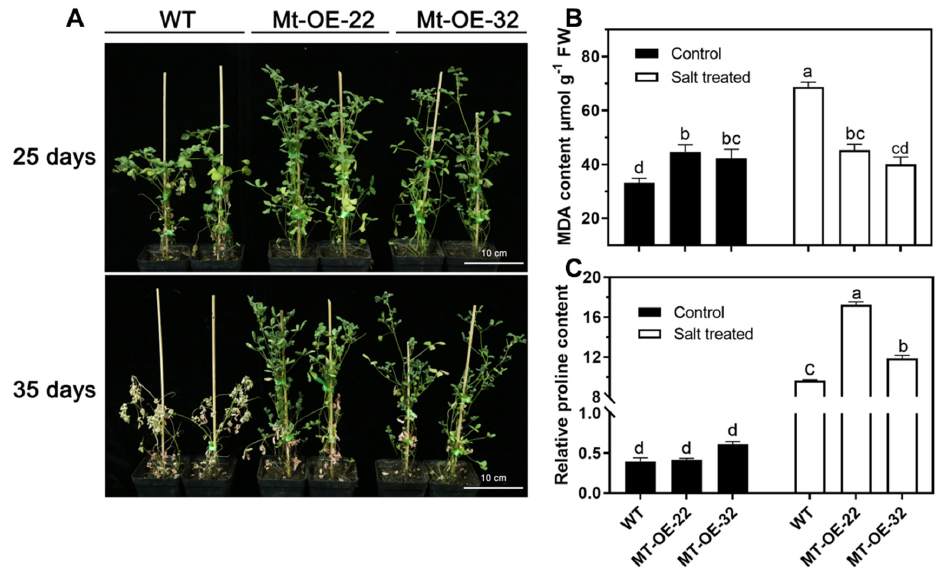
Figure 4. Growth and physiological differences of Mtr-miR319a- overexpressed M. truncatula plants after salt stress: phenotype ( A ); physiological indicators of MDA content ( B ); relative proline content (C) of M. truncatula plants overexpressing Mtr-miR319a after salt stress. The WT M. truncatula plants and Mtr - miR319a- overexpressing lines of Mtr-OE-22 and Mtr-OE-32 were exposed to salt stress of 200 mM NaCl for 25 d ( A ) and 35 d ( A – C ). The values are shown as the mean ± standard error (SE); n = 3 for the groups. The bars represent the SE. Bars with different lowercase letters indicate statistically significant differences at p < 0.05 based on ANOVA. Bar = 10 cm.